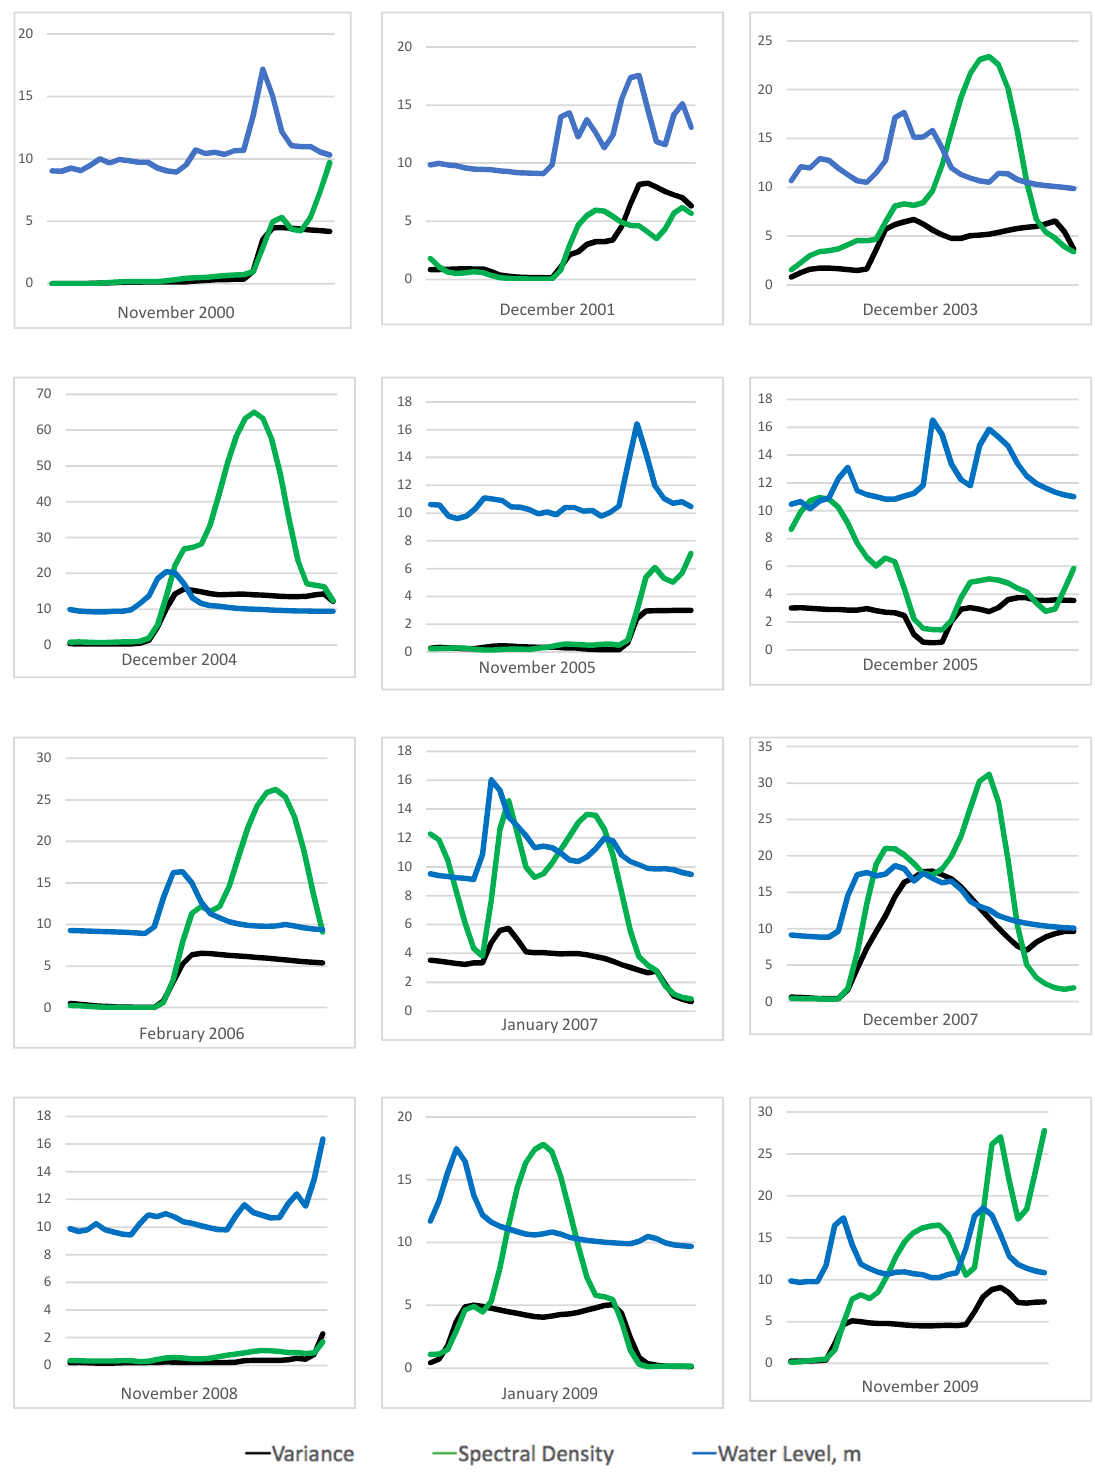
Figure 3. Trend of the time series of water level and the time series of the critical slowing down indicators, variance, and the average spectral density at low frequencies for all twelve flood events at Kelantan River from 1 January 2000 until 13 October 2010.